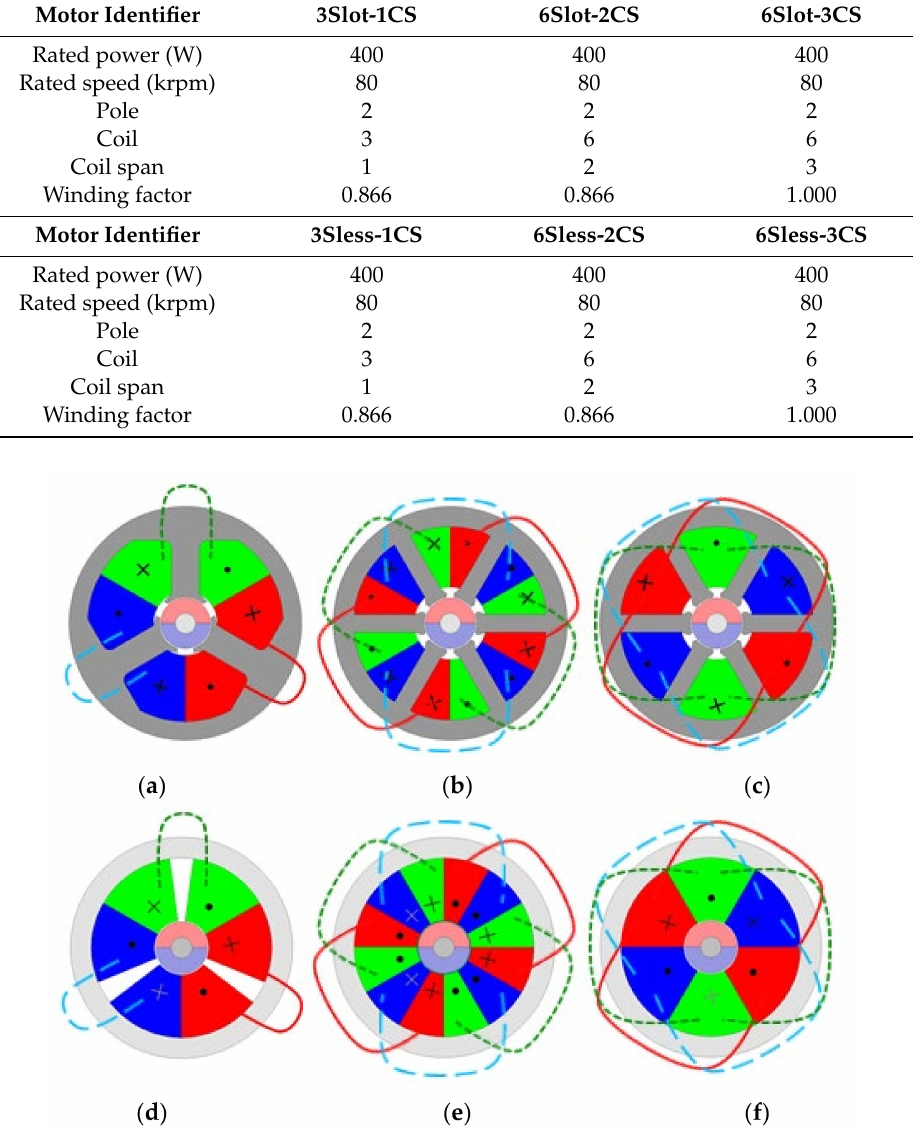
Figure 2. The corresponding FEA (Finite Element Analysis) models of six di ff erent analyzed PM motors: ( a ) 3Slot-1CS, ( b ) 6Slot-2CS, ( c ) 6Slot-3CS, ( d ) 3Sless-1CS, ( e ) 6Sless-2CS, and ( f )